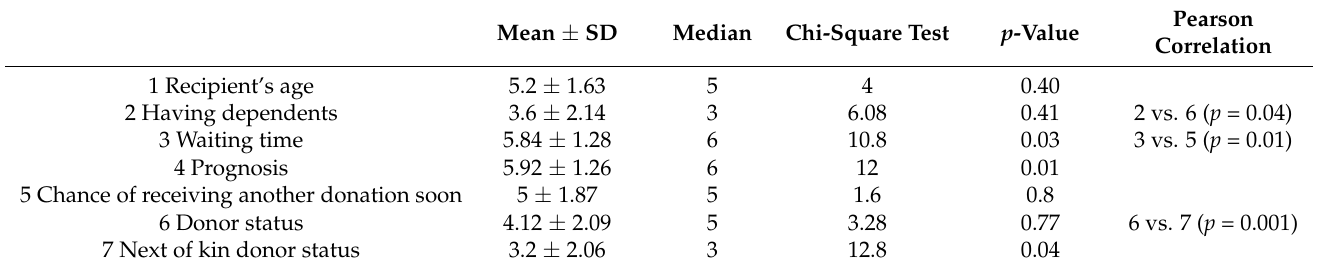
Table 3. Analysis of organ allocation criteria.